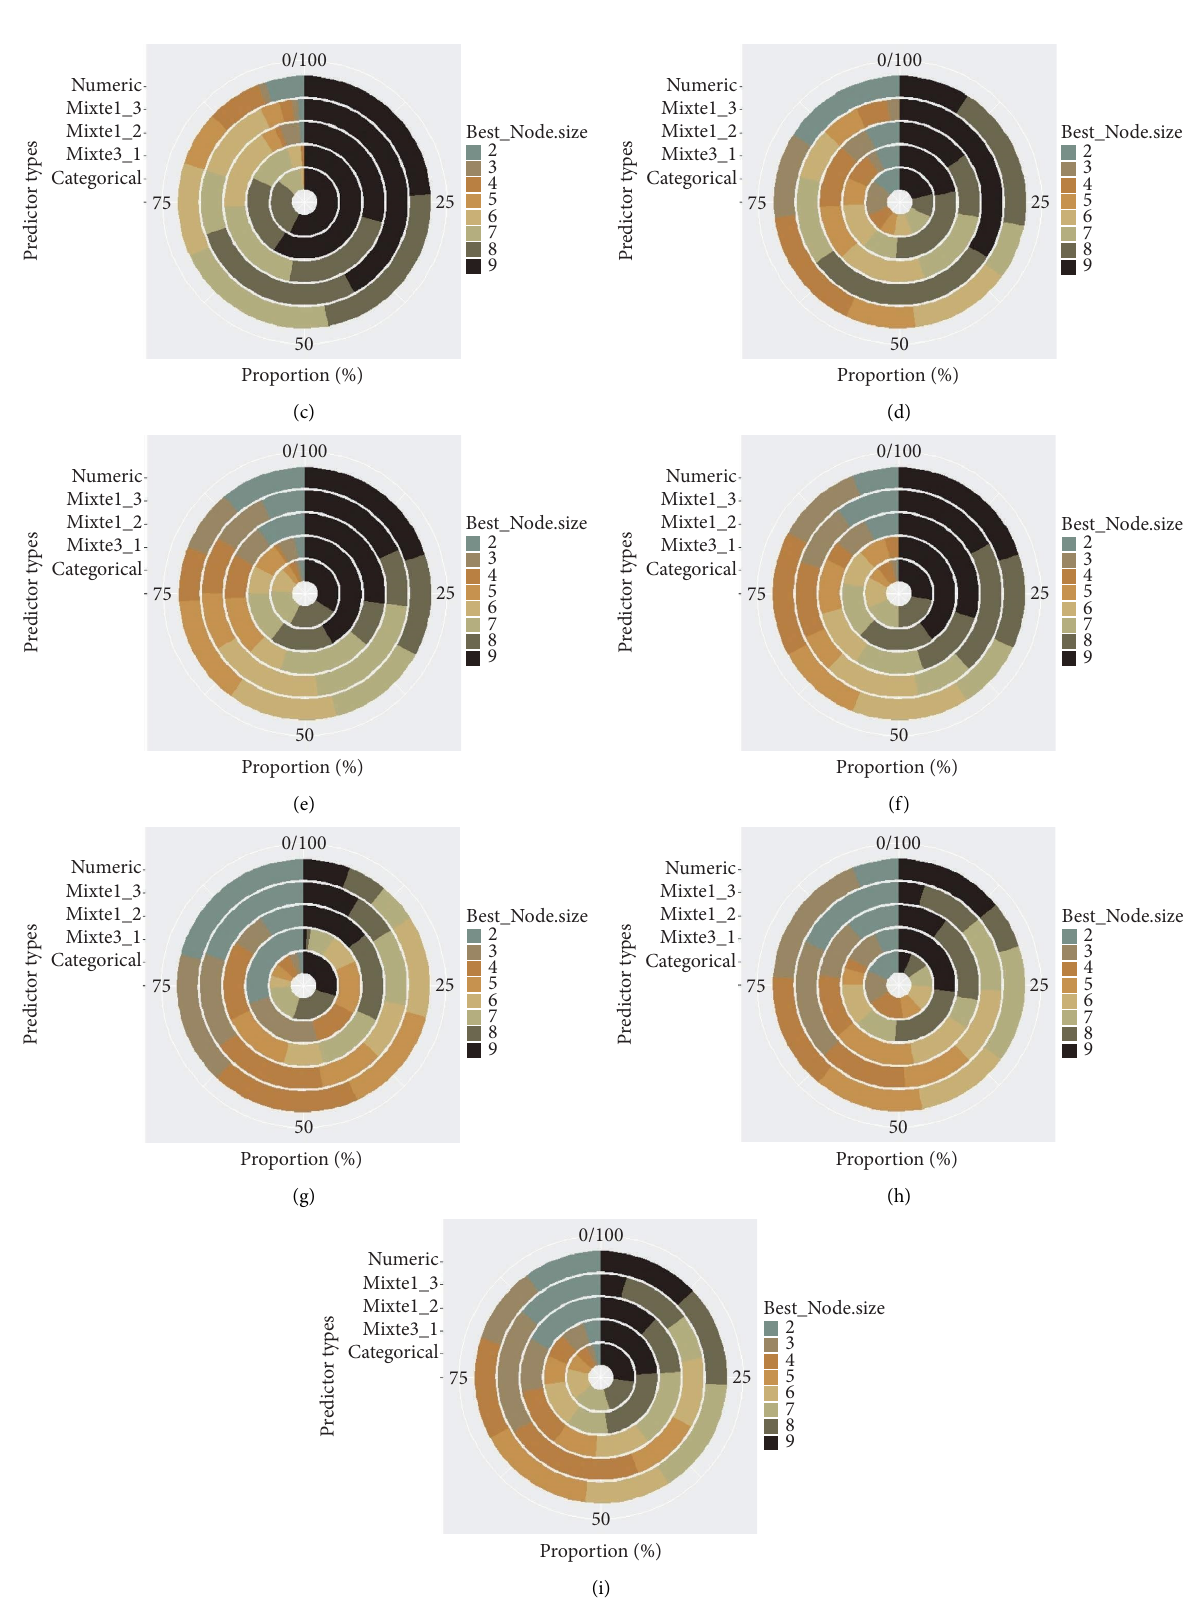
Figure 3: Best RF node size as a function of the population size, number, and type of predictors (Numeric � 100% are quantitative predictors, Mixt1 3 � 25% are quantitative predictors, Mixt1 2 � 50% are quantitative predictors, Mixt3 1 � 75% are quantitative pre- dictors, and Categorical � 100% are categorical predictors). (a) N � 50 ,P � 8, (b) N � 250 ,P � 8, (c) N � 1250 ,P � 8, (d) N � 50 ,P �